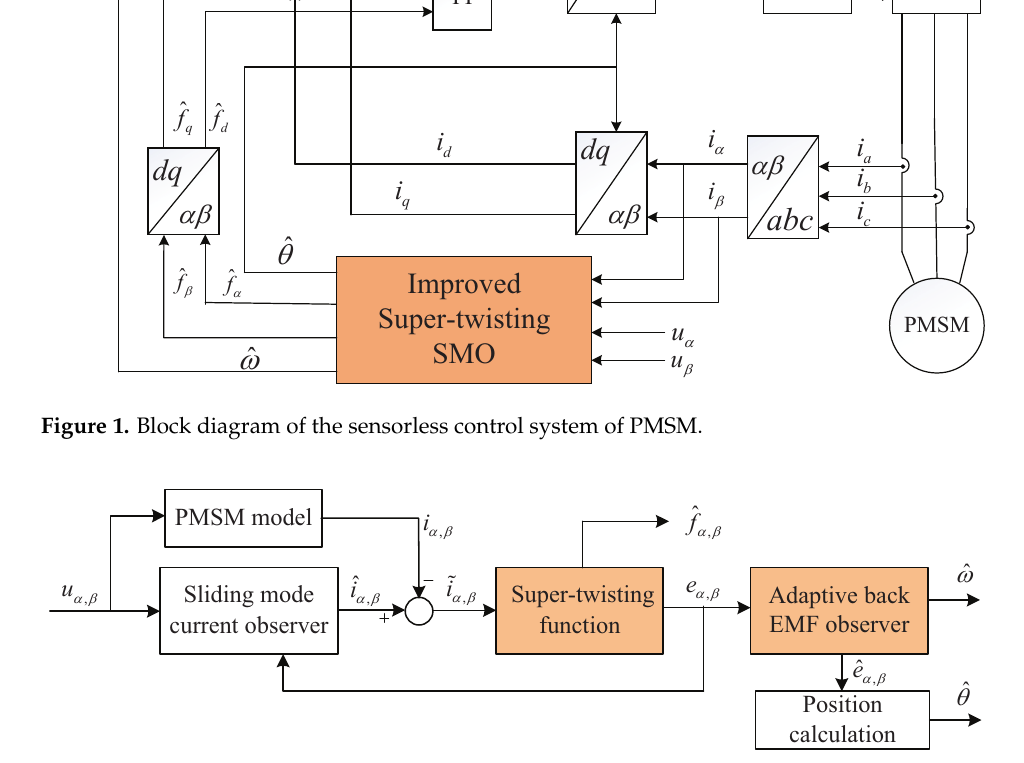
Figure 2. Block diagram of the improved super-twisting